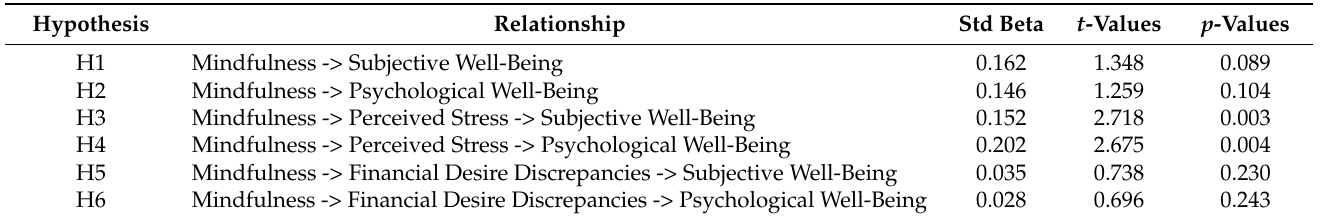
Table 7. Path Coefficients.